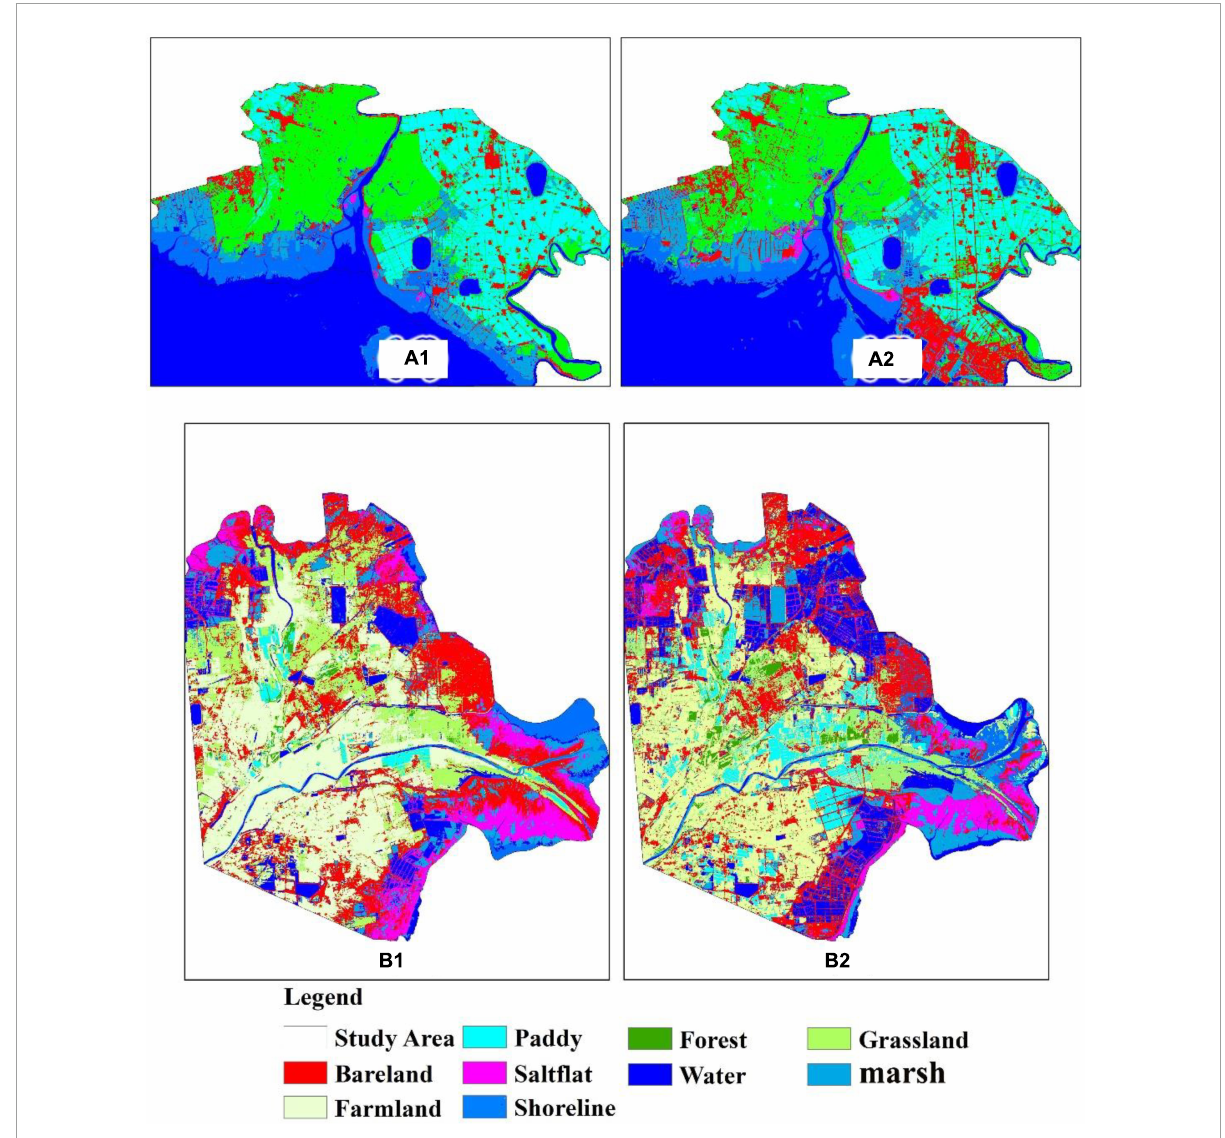
FIGURE6 Classification results of (A) Shuangtai Estuary and (B) Yellow River Delta. (A1,B1) and (A2,B2) represents 2005 and 2015,